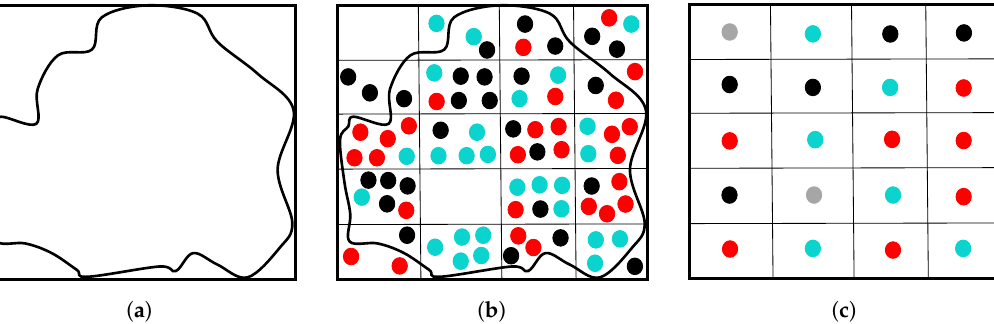
Figure 1. Resampling of classified points: turquoise, black, and red represent points of three different classes, and grey points represent unclassified resampled points. ( a ) Extent of study area. ( b ) Pixel-size identification. ( c ) Point resampling into the